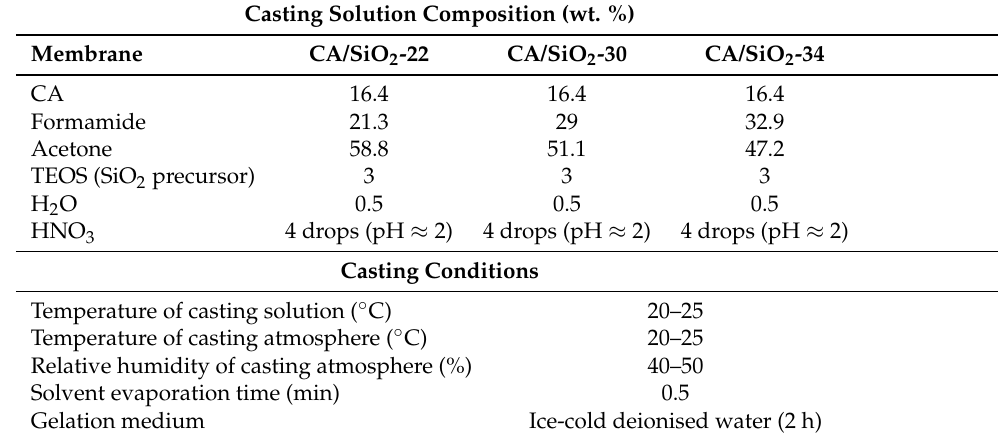
Table 1. Film casting solution compositions and casting conditions of CA/SiO 2 hybrid membranes. Casting Solution Composition (wt.